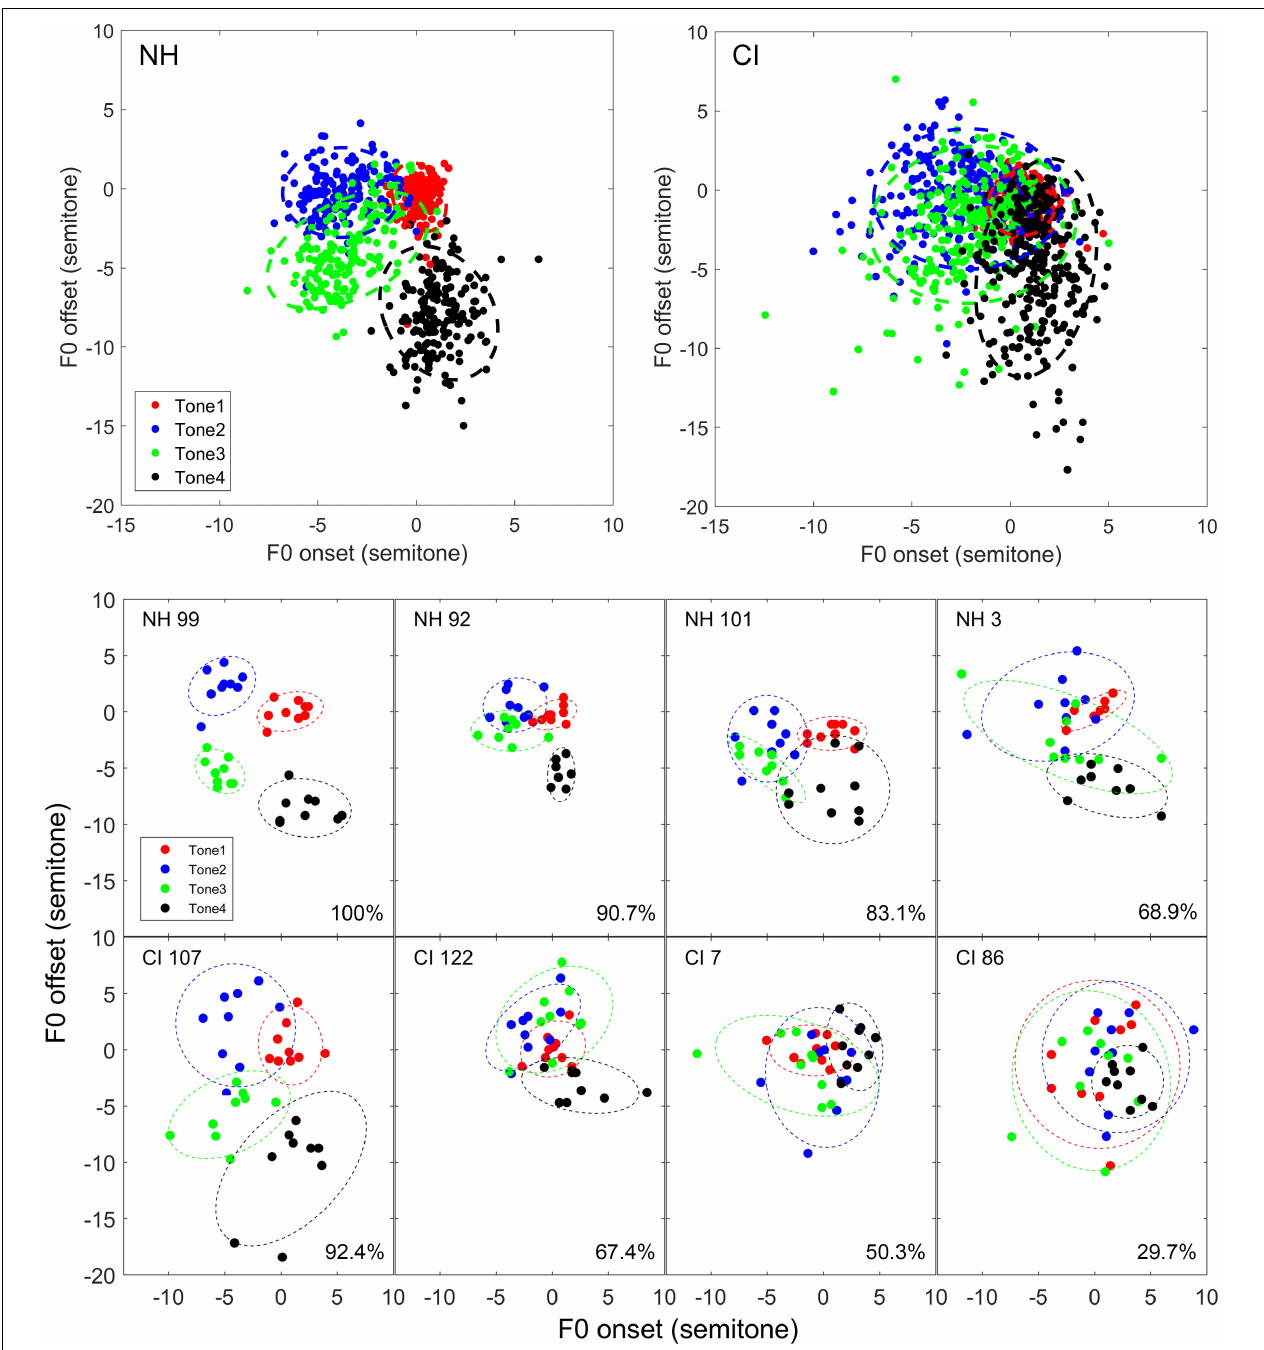
FIGURE 1 | Tone ellipses based on F0 onset and offset values (2D method). Upper panels: Tone ellipses of the NH (left) and CI (right) groups. Each symbol represents the mean data of one subject. Lower panels: Tone ellipses of individual representative subjects. For either NH or CI group, four subjects were randomly selected based on their mean tone differentiability scores in the interval of 75th–100th, 50th–75th, 25th–50th, and 0–25th quantiles in the respective groups. Mean differentiability score is displayed in the lower right corner. Each data point represents a pair of F0 onset–offset values of a produced token. Four different colors represent four different tone types, as indicated in the legend.